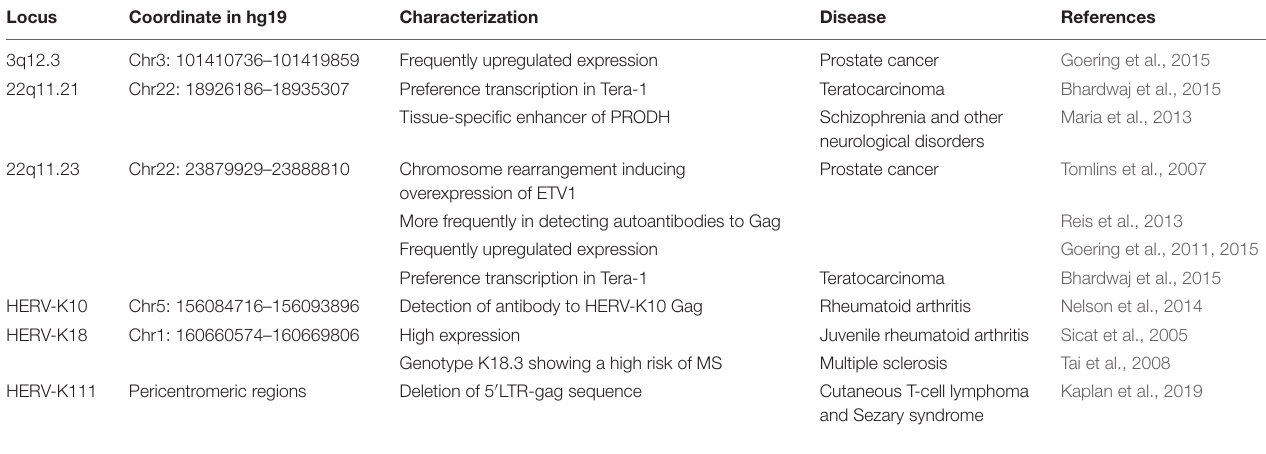
TABLE 2 | Disease-related specific HERV-K (HML-2)